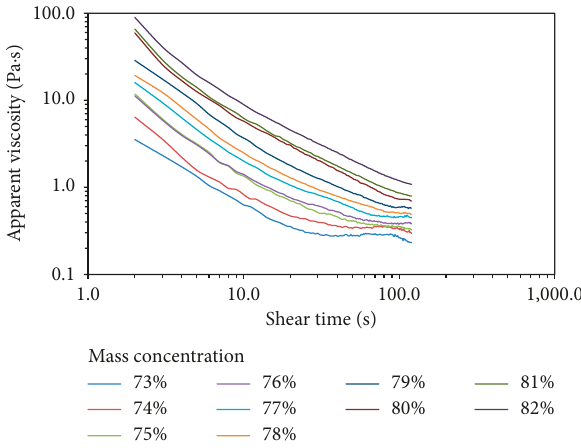
Figure 3: Relationship between apparent viscosity and shear time of different slurry mass concentrations.